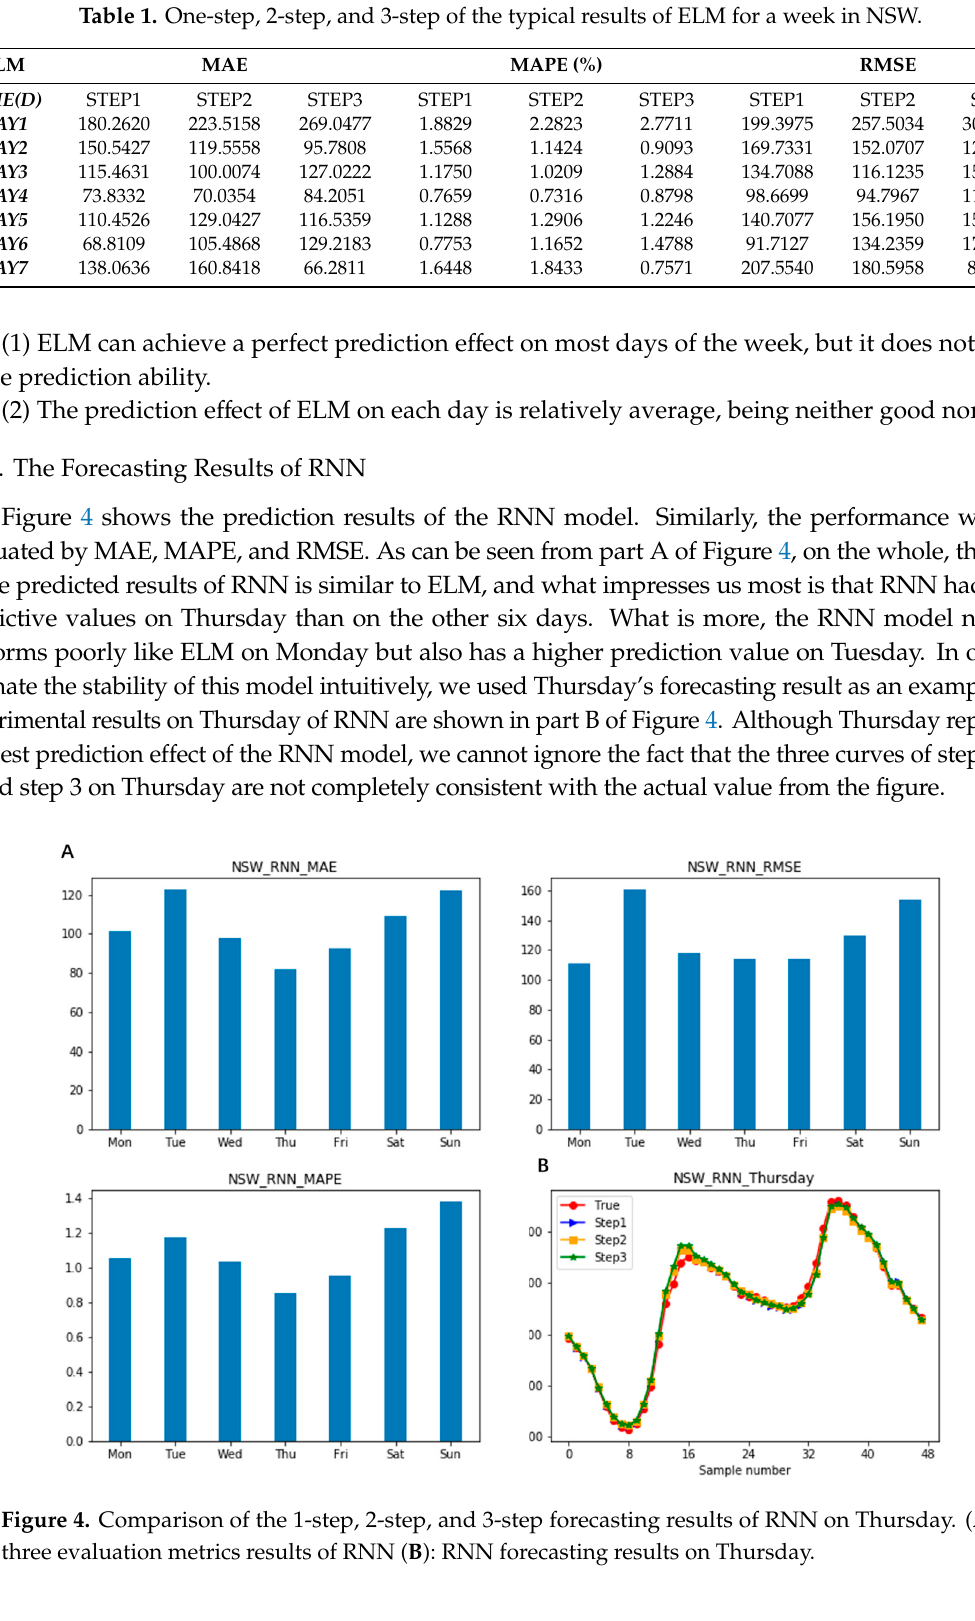
Table 1. One-step, 2-step, and 3-step of the typical results of ELM for a week in NSW.